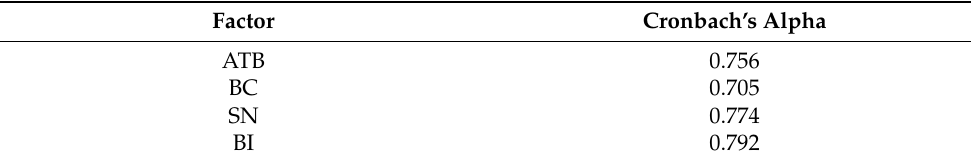
Table 3. Reliability Index—Cronbach’s Alpha.